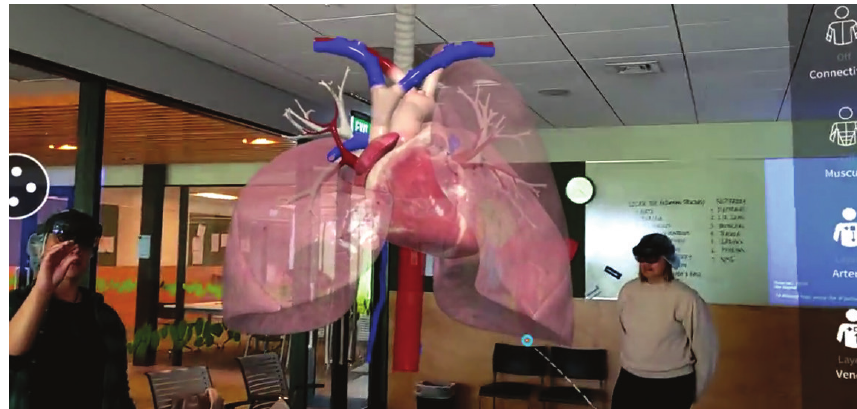
Figure 3. Student view of the GIGXR HoloHuman app on HoloLens 2 at Toi Ohomai / Te P ū